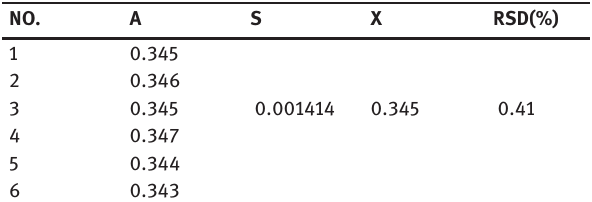
Table 1: Results of precision experiment. (n=6).